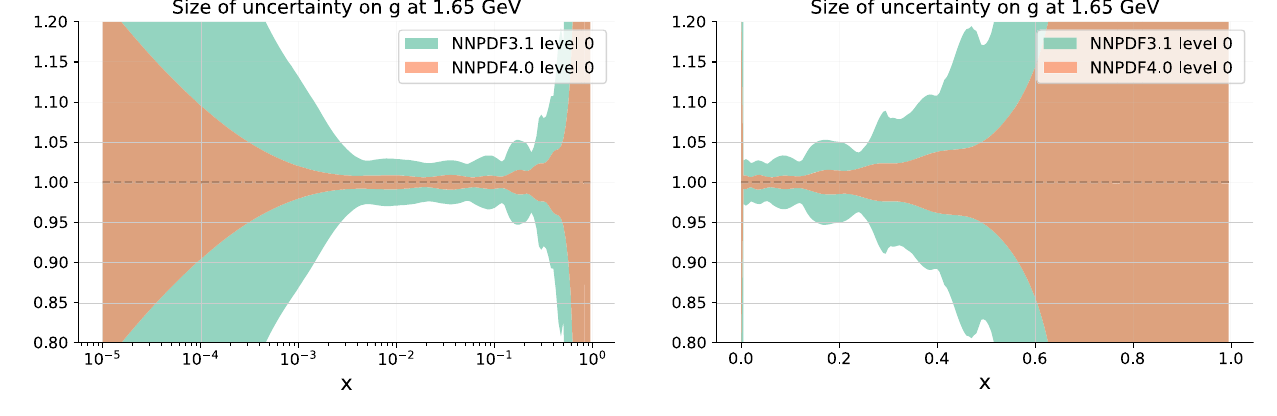
Fig. 6 Level 0 uncertainty in the NNPDF4.0 and NNPDF3.1